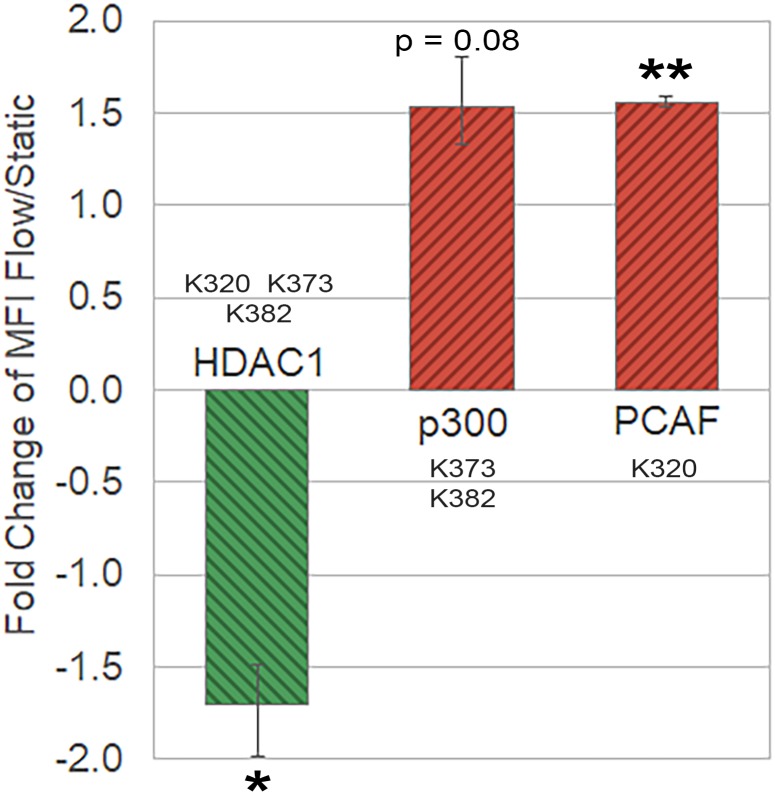
Shear flow exposure modulates expression of acetyl-modifying enzymes.Fold change of mean fluorescence intensity (MFI) in d9 Mks before and after shear-flow exposure for p53 deacetylase (HDAC1) and acetyltransferases (p300/PCAF). Quantification was achieved using an ELISA. One sample t-test, *p < 0.05, **p < 0.01. n = 3 (biological replicates), error bars: SEM. Scale bar: 5μm.